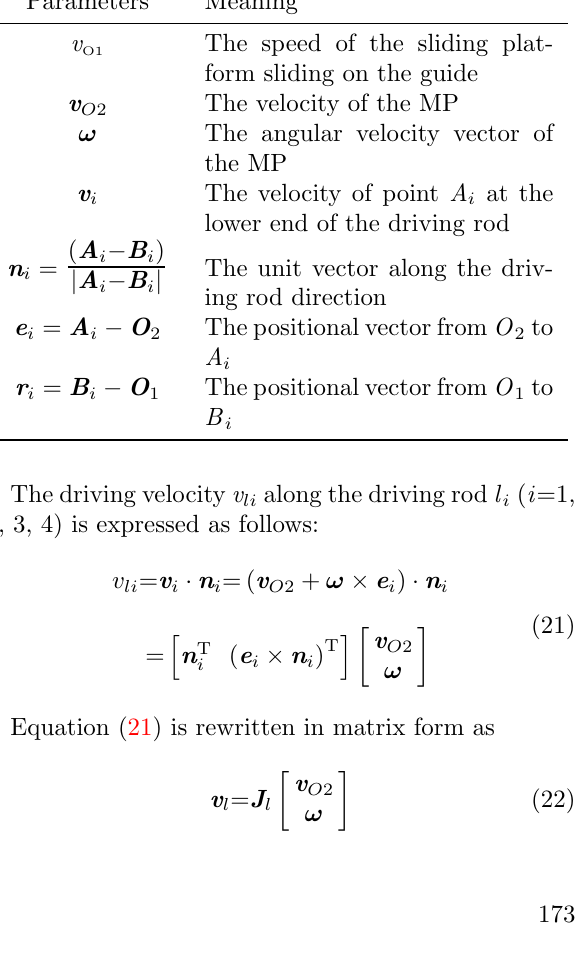
Figure 6: The velocities of the 5-DOF GHMT